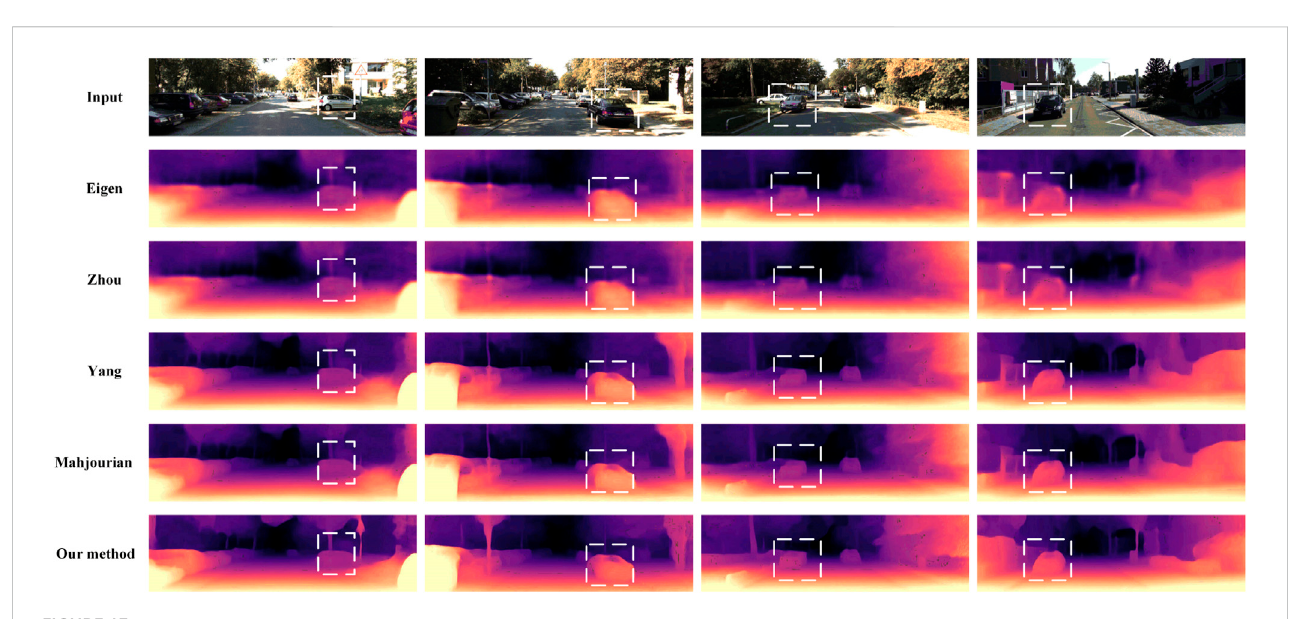
FIGURE 13 Visual comparison experimental results with other related research algorithms on the KITTI dataset: the fi rst row is the input two-dimensional color image; rows 2 to 6 show the depth maps predicted by Eigen, Zhou, Yang, Mahjourian et al. and our method,